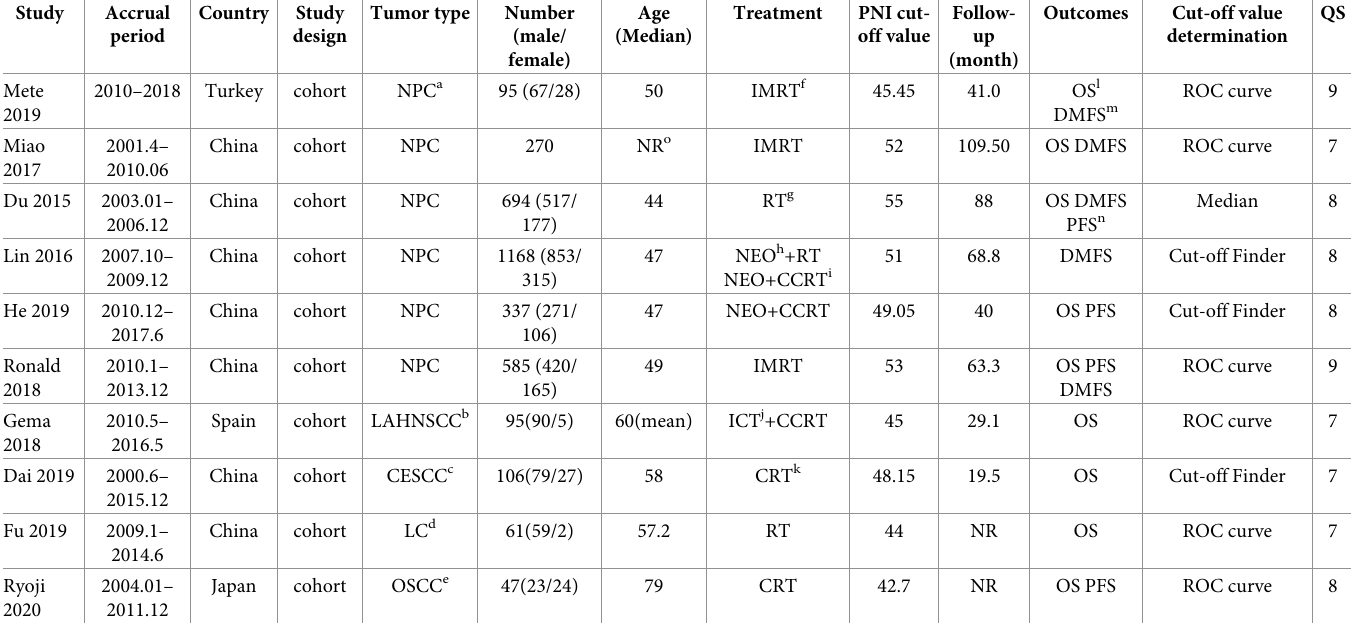
Table 1. The baseline characteristics of the included